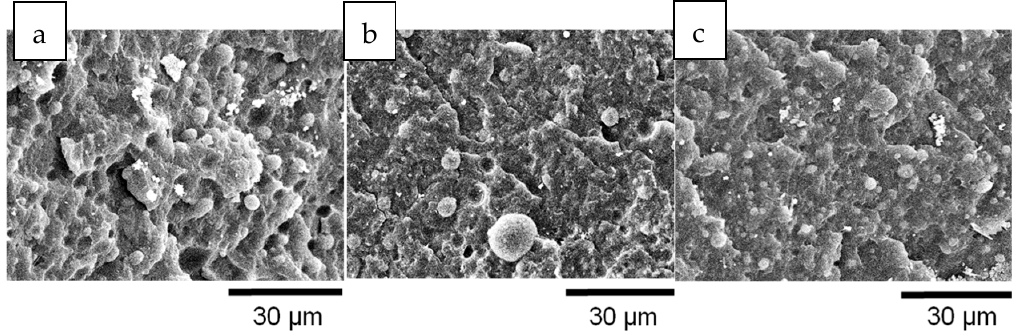
Polymers 2019 , 11 , x FOR PEER REVIEW 10 of 24 Figure 4. SEM images of PBNANO-12% containing: ( a ) hydrophilic (hphi), ( b ) hydrophobic (hpho), and ( c ) hydrophobically modified (hphoM) TiO 2.